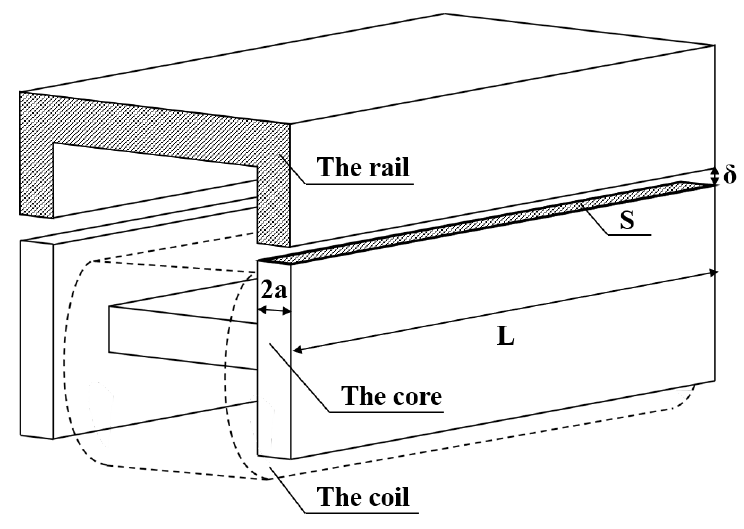
Figure 1. Three dimensional schematic diagram of the single suspension magnet model.